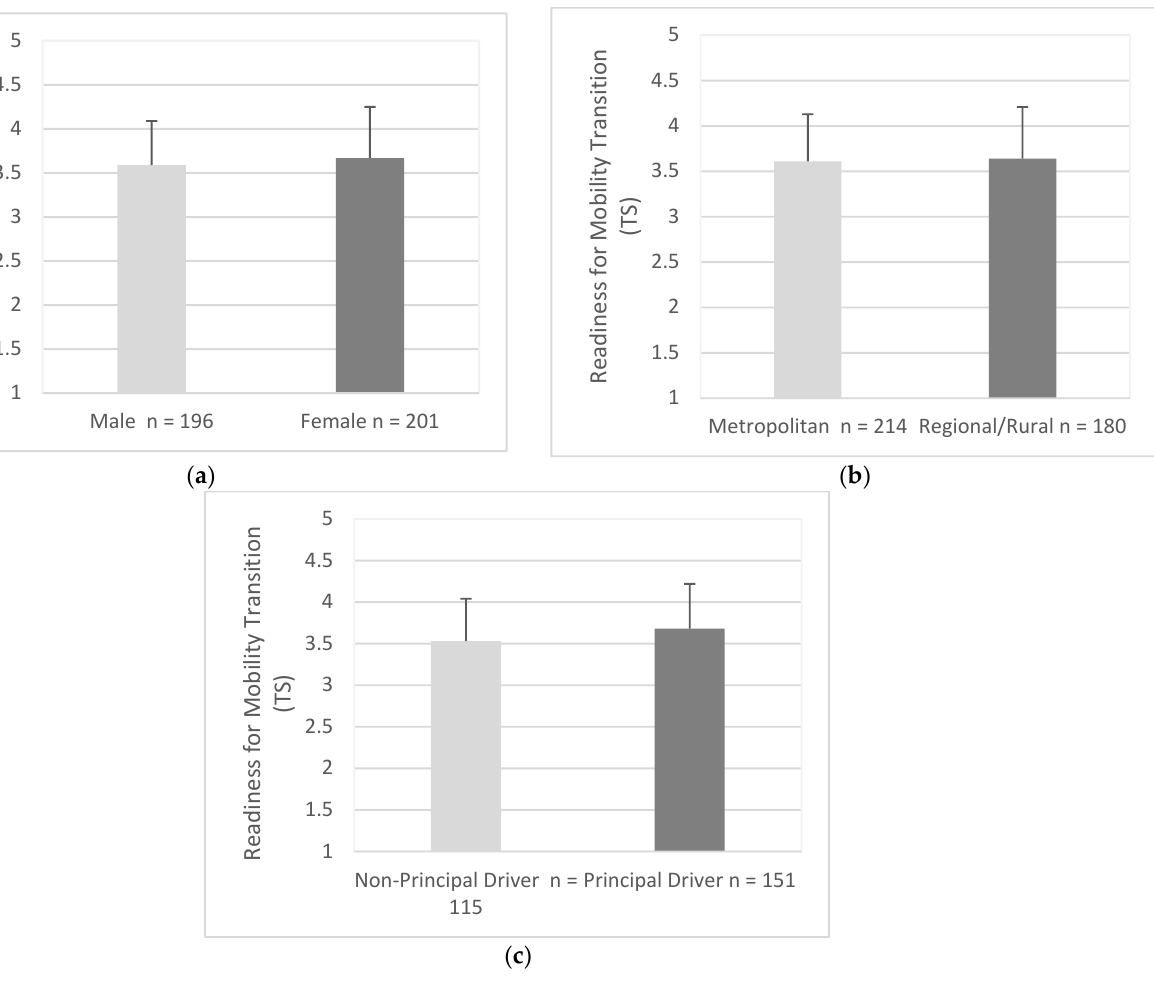
Figure 6. Mean score for readiness as endorsed by participants in each group; ( a ) Gender, ( b ) Residential Area, ( c ) Driving Roles. Items were measured using responses of 1 (strongly disagree) to 5 (strongly agree). Error bars represent standard deviation.